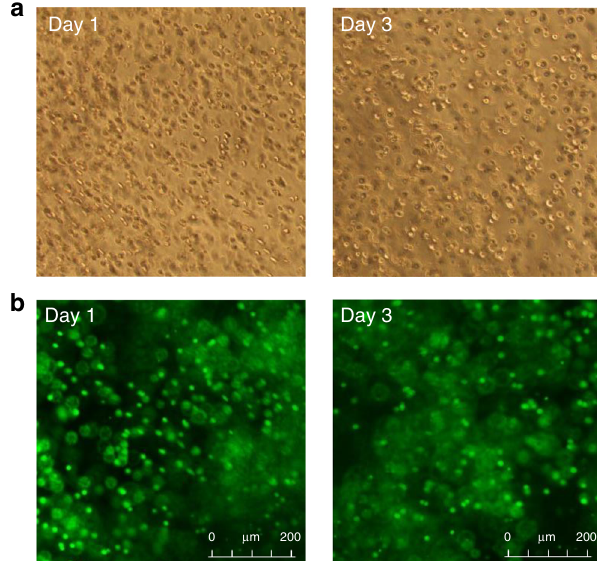
Fig. 7 Cell viability studies. a Bright- fi eld images of hydrogels containing encapsulated fi broblasts (L929); and b live/dead staining of the cell-laden hydrogels after 1 day and 3 days of 3D culture, showing cell viability ≥ 80% (live cell = green, dead cell = red).